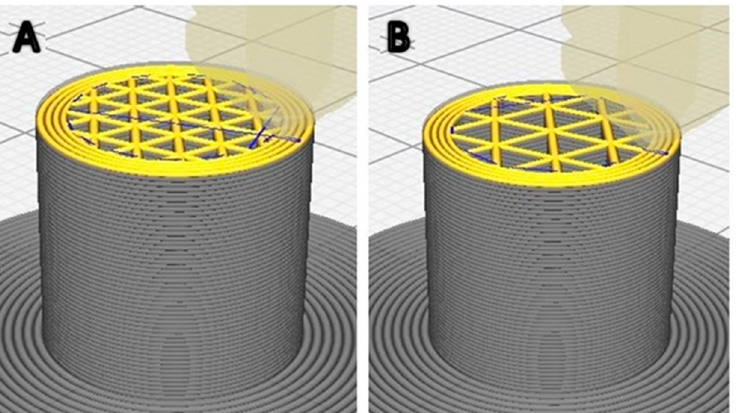
Figure 3. 3D modeling images of the 3D-printed samples (from Cura 3.4.1 software) with different infill line distance designed in this study. (A) 1.6 mm ILD, (B) 2.4 mm